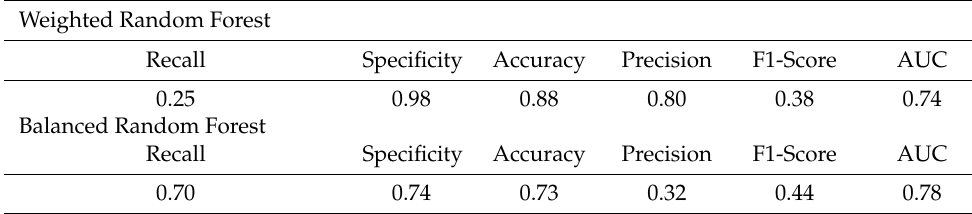
Table 10. Performance metrics of random forest